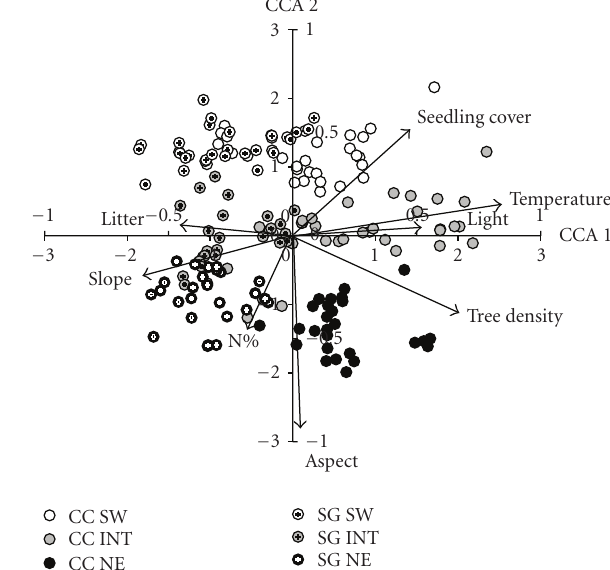
Figure 4: Canonical correspondence analysis (CCA) ordination of 192 seed bank samples by aspect class (see text) in revegetating clearcut and mature second-growth forest samples. See text for description of